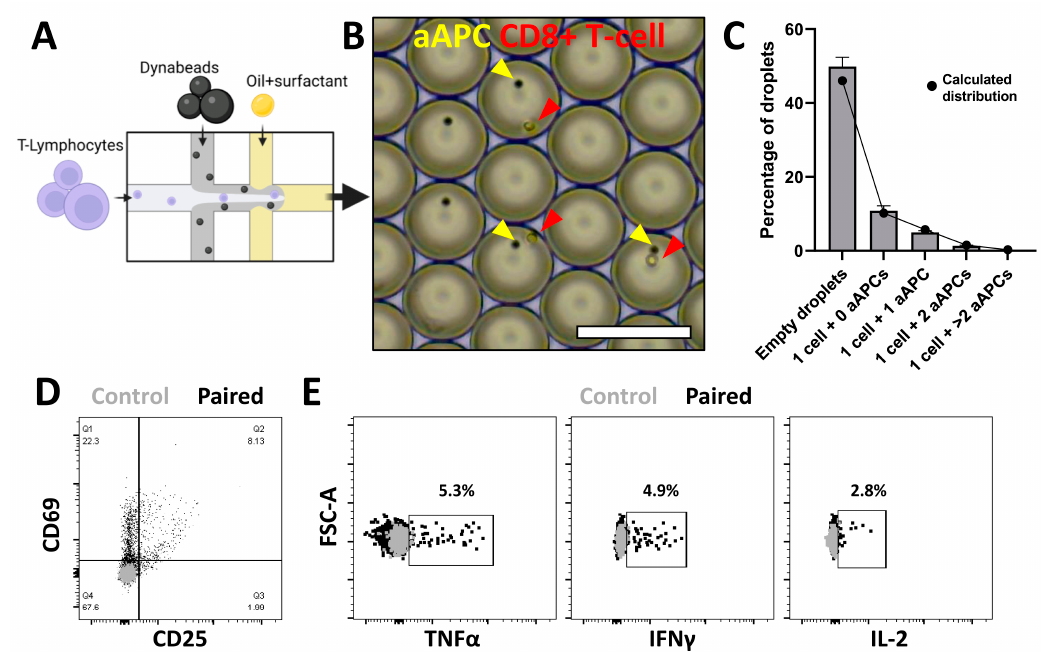
Figure 2. Single-cell CTL activation using aAPCs. ( A ) Schematic of droplet formation when CTLs are paired with Dynabeads. ( B ) Brightfield microscopy image of aqueous droplets containing CTLs (red) and aAPCs (yellow) in pairs. Scale bar = 100 µm. ( C ) Counted (grey bars) and calculated (black dots) Poisson distribution of droplet contents when co-encapsulating CTL and aAPCs. Error bars represent average ± SEM of 4 independent experiments in which at least 1000 droplets were counted. ( D ) Marker expression of CD69 and CD25 activation markers on CTLs retrieved from droplet co- culture with aAPC. ( E ) Cytokine secretion of CTLs retrieved from droplet co-culture with aAPCs (black dots) as compared to unstimulated control (grey dots).